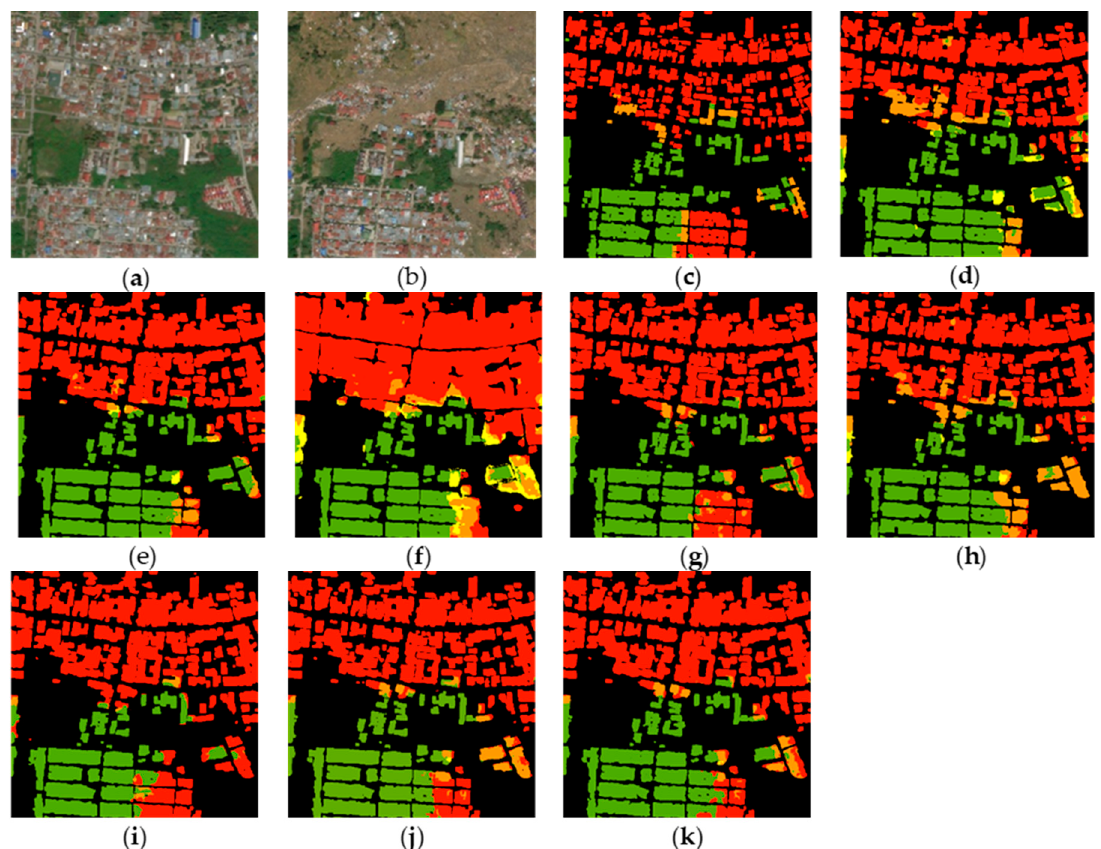
Figure 12. Palu_00000181 in the verification set. ( a ) A pre-disaster image, ( b ) a post-disaster image and ( c ) the GT. ( d ) The result of ResNet (w/o A), ( e ) the result of SEresNeXt (w/o A), ( f ) the result of DPN (w/o A), ( g ) the result of SENet (w/o A), ( h ) the result of ResNet (w A), ( i ) the result of SEresNeXt (w A), ( j ) the result of DPN (w A) and ( k ) the result of SENet (w